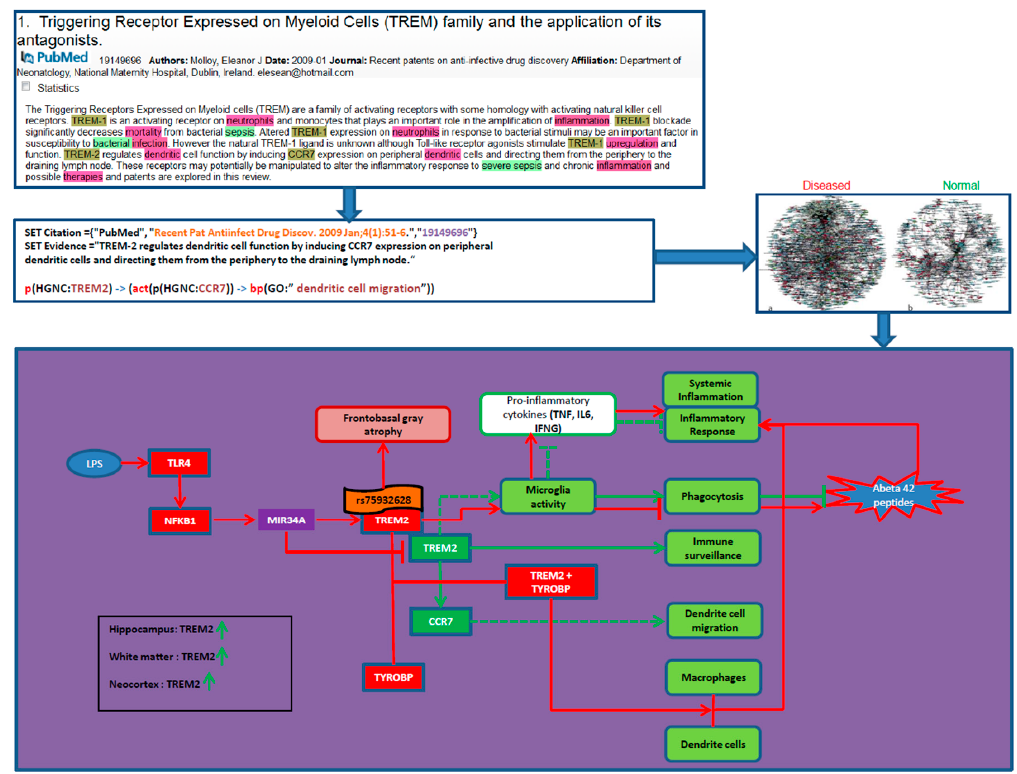
Figure 2. Differential analysis of triggering receptor expressed on myeloid cells 2 (TREM2) activities in neuroinflammation and normal state: In this figure dotted lines indicates regulation, arrows represent increase relation and T shaped lines represent inhibits/decrease relation. Red colored nodes and edges indicate the disease state mechanisms whereas green colored nodes and edges show normal state processes. The highlighted words in the uppermost screenshot represent the entity (term) markup in text by the text mining tool used.